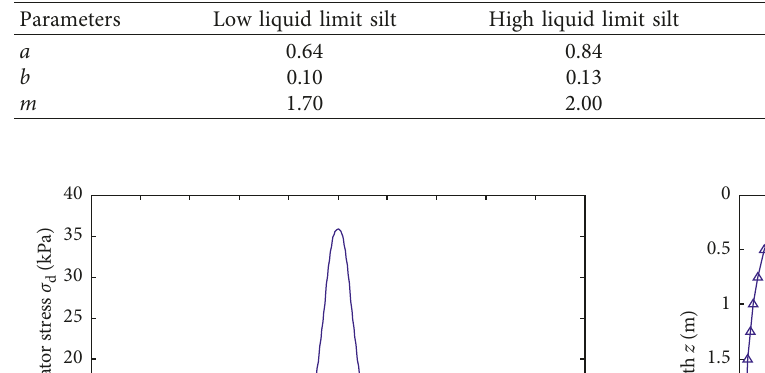
Table 3: Different soil material parameter values.